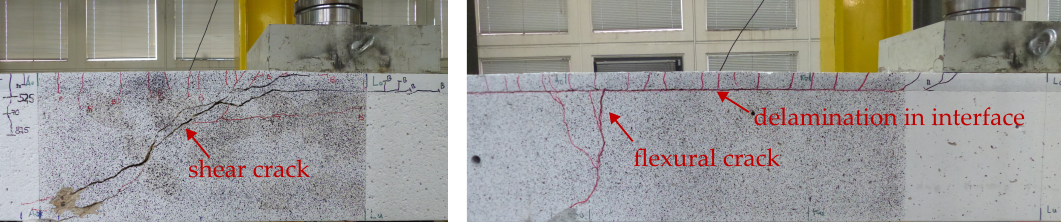
Figure 12. Essentially distinguished cracks related to failure (photos and graphic by IMB, RWTH Aachen